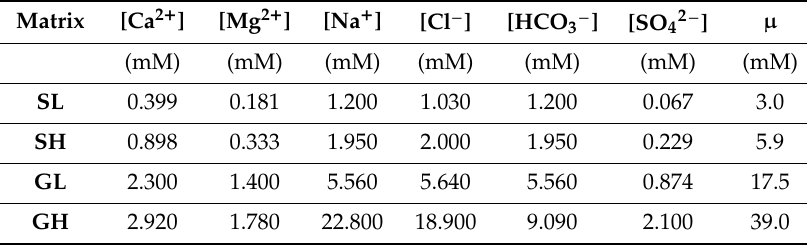
Figure 2. pH dependence of (i) the iron corrosion mechanism (i.e., hydrogen evolution, oxygen corrosion) and (ii) the specification of dissolved substances (A 2 − , AH − , AH 2 ). The solid phases existing in Fe 0 / H 2 O systems (mainly oxides) can be considered as poly-electrolytes. Each solid phase is characterized by an isoelectric point (pHpzc = pzc = “point of zero charge”). Above the pHpzc, the solid oxide surface is negatively charged. AH 2 is a weak electrolyte with two acidity constants (pKa values). Similar to pHpzc values, pKa values are the limit of the predominance ranges (A 2 − / AH − and AH − / AH 2 ). Table 1. Composition of the four water matrices used by He ff ron et al. [142]. Ion concentrations are in mmol L − 1 (mM). The solutions were prepared using Milli-Q water and analytical grade reagents. The synthetic waters are SL (Surface Low), SH (Surface High), GL (Ground Low), and GH (Ground High). High and Low are related to the ionic strength ( µ ).